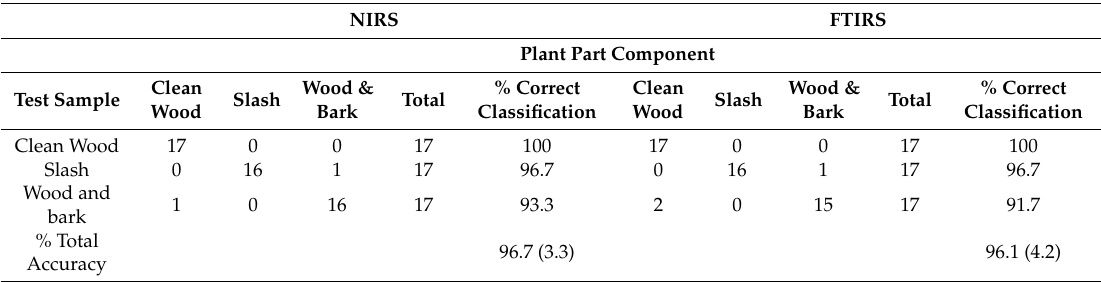
Table 5. Classification rates for forest logging residue 1